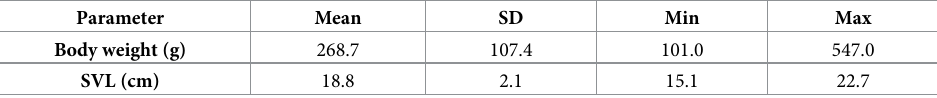
Table 3. Descriptive statistics for the body weights and SVL for 22 bearded dragons used in the contrast study.